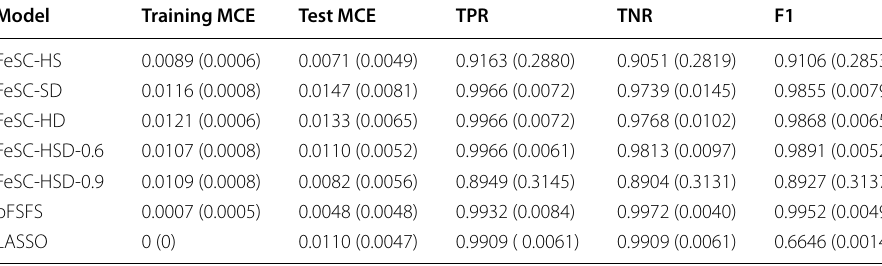
Table 2 Training and test MCE in the SS dataset across 10 runs. Results are expressed in terms of average (standard deviation)